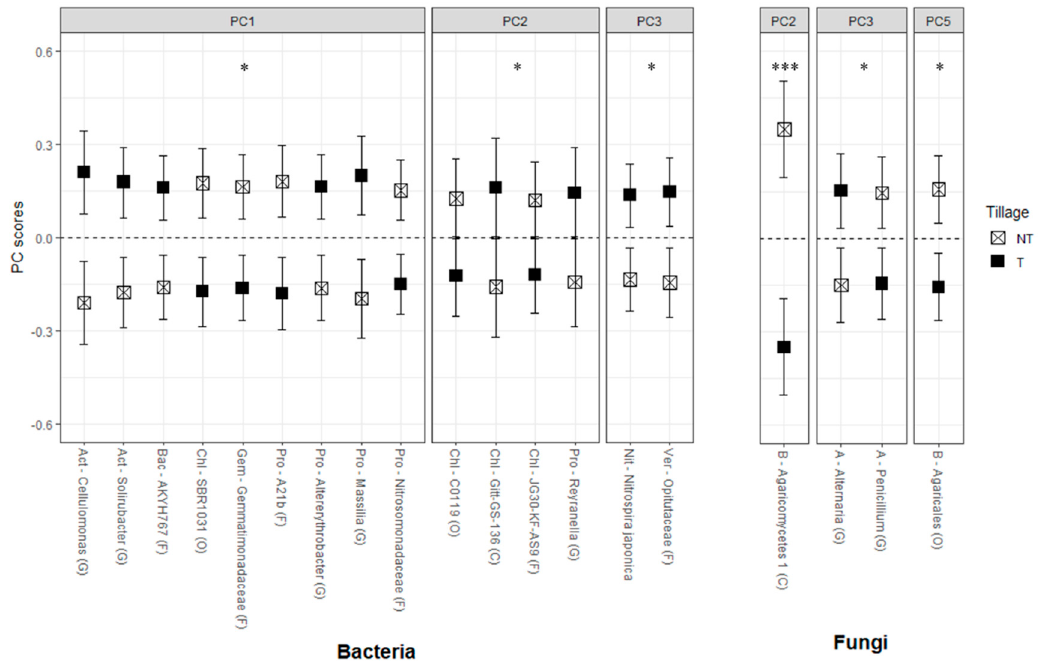
Figure 1. Response pattern of the bacterial and fungal indicator OTUs to tillage. Visual representation of the combined results of the principal component analyses (PCAs) and their mean separation procedure showing the most responsive bacterial and fungal indicator OTUs based on their effects on the relative abundances following five years of tillage within corn–soybean rotations. For each taxon, the response of each OTU to tillage treatments (chisel tillage (filled square), no-till (crossed square)) was calculated as the mean PC score multiplied by the PC loading score of a given OTU. Likewise, the whiskers represent the standard error of the mean PC scores for each tillage treatment multiplied by the absolute value of each OTU loading. The x -axes show the three-letter acronym of the OTU’s phylum, followed by the name of the OTU’s lowest identified taxonomic rank and that rank in parentheses. Act, Actinobacteria; Bac, Bacteroidetes; Chl, Chloroflexi; Gem, Gemmatimonadetes; Pro, Proteobacteria; Nit, Nitrospirae; Ver, Verrucomicrobia; A, Ascomycota; B, Basidiomycota; C, Class; O, Order; F, Family; G, Genus. *, ***, significant at the 0.1 and 0.01 probability levels, respectively.